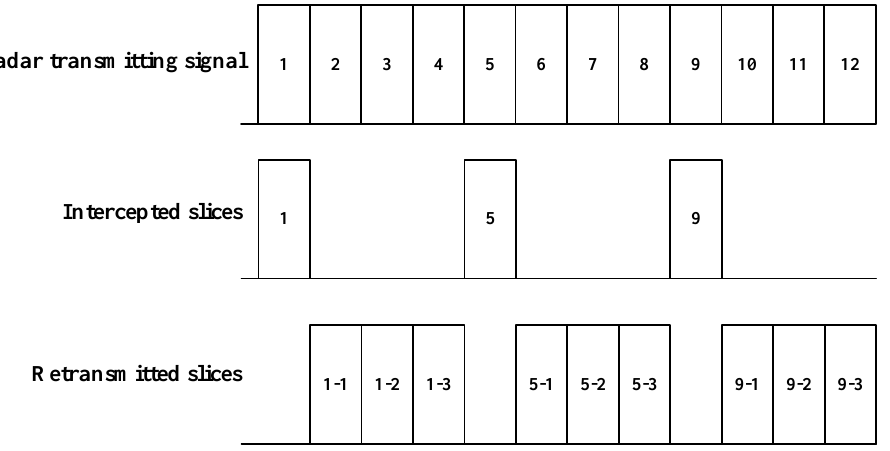
Figure 1. Mechanism of interrupted sampling repeater jamming (ISRJ).